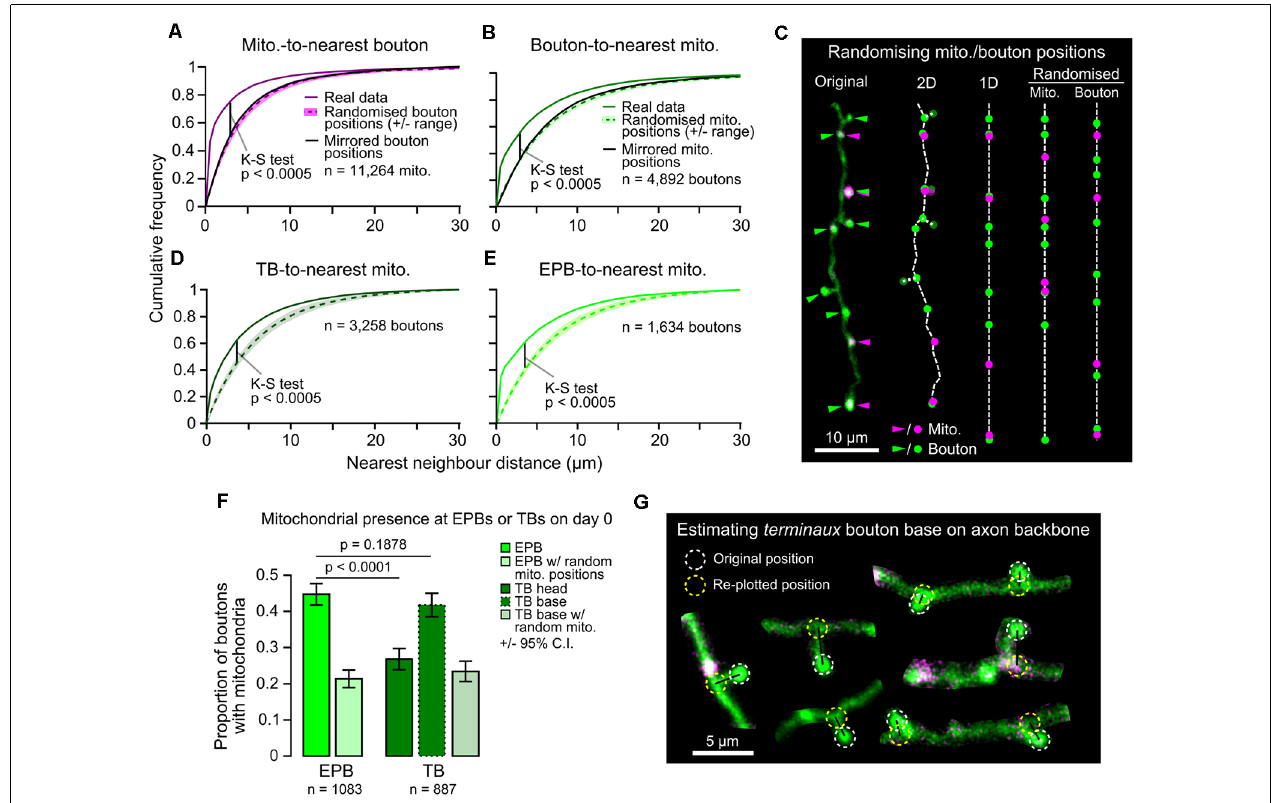
FIGURE 3 | Mitochondria are positioned more closely to en passant boutons (EPBs) than terminaux boutons (TBs). (A) The distribution of distances between each mitochondrion and its nearest bouton was plotted against the results from 1,000 rounds of randomized positioning of boutons for comparison to chance levels. Median ± range ( shaded area ). Kolmogorov–Smirnov ( K–S ) test between real data and the median of randomized positioning. As a further control, the real bouton positions were mirrored along the axon backbone to maintain the inter-bouton distances ( black line ) resulting in a similar distribution to the randomized positioning. (B) Same as in (A) , but for boutons and their nearest mitochondrion compared to results from randomized/mirrored positioning of mitochondria. (C) Illustration of the routine for randomizing positions. The original image was manually traced and a 2D skeleton interpolated from the segmented line trace. TBs were approximately placed at the nearest point on the axon backbone (their base) for randomizing in 1D. The 2D skeleton was then straightened to 1D and either mitochondria were randomly positioned alongside real bouton positions or vice versa. (D,E) Same as in (B) , but for TBs only ( D ; using TB base position, see G ) or EPBs only (E) . (F) A greater proportion of EPBs have mitochondria within a biologically relevant distance (1.5 µ m, see “Materials and Methods” section) than TBs (day 0 data; Chi-squared test). When mitochondrial localization was considered from the TB base instead of the head the difference was lost (Chi-squared test). Error bars ± 95% CI. (G) Estimated location of TB bases was achieved by finding the nearest neighbor point on the axon backbone that was closest to the TB head and re-plotting the TB to that position. 2P images were cropped for easier visualization.